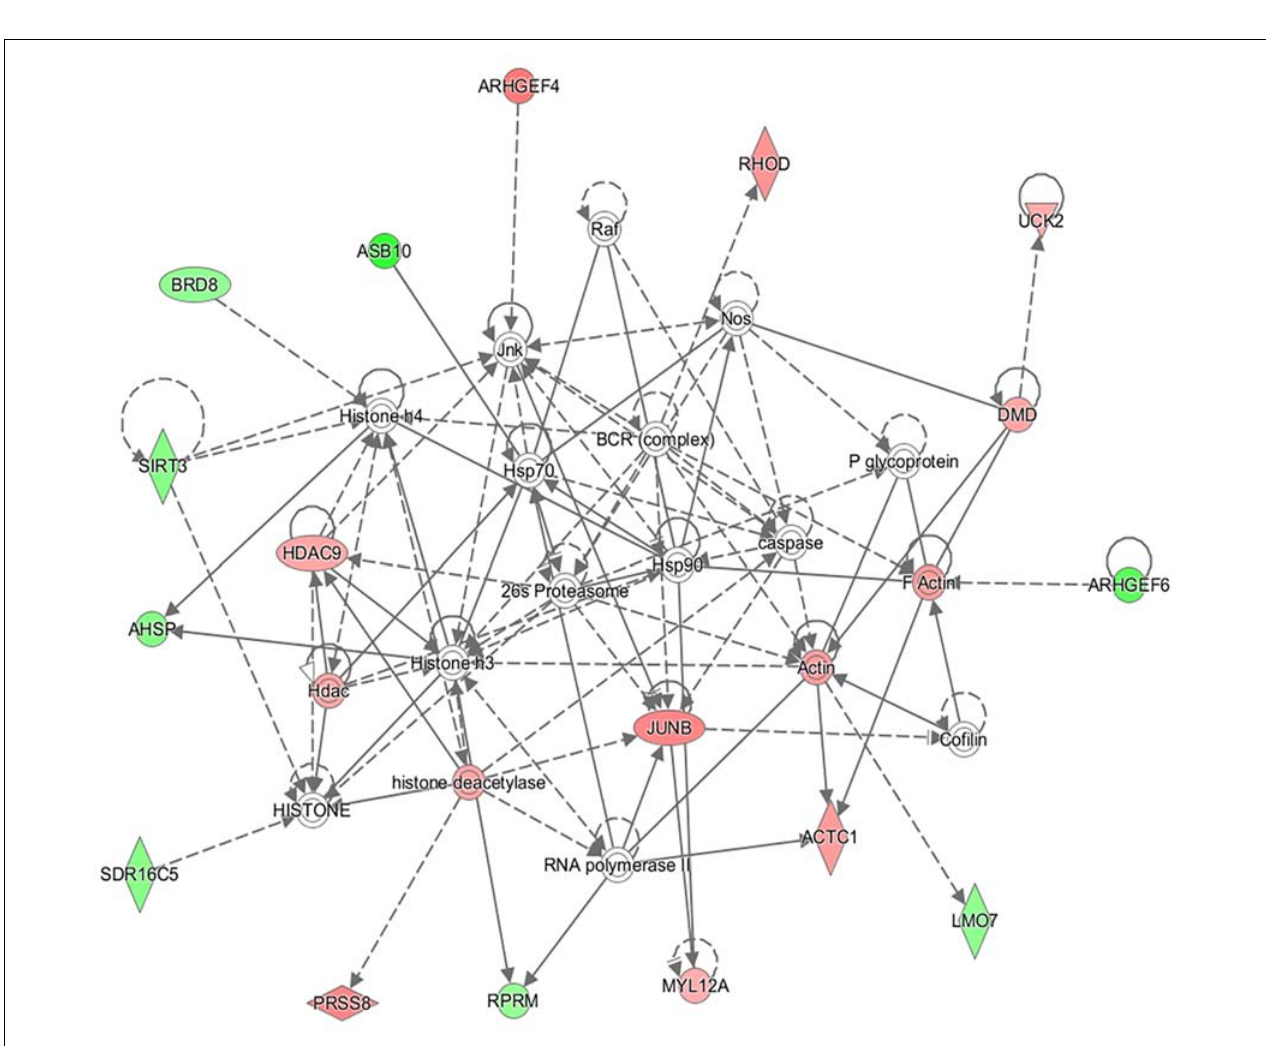
FIGURE 3 | Gene network 1: Cell Morphology, Organ Morphology, Skeletal and Muscular System Development and Function. Genes upregulated and downregulated in the H group are represented by green and red colors, respectively.